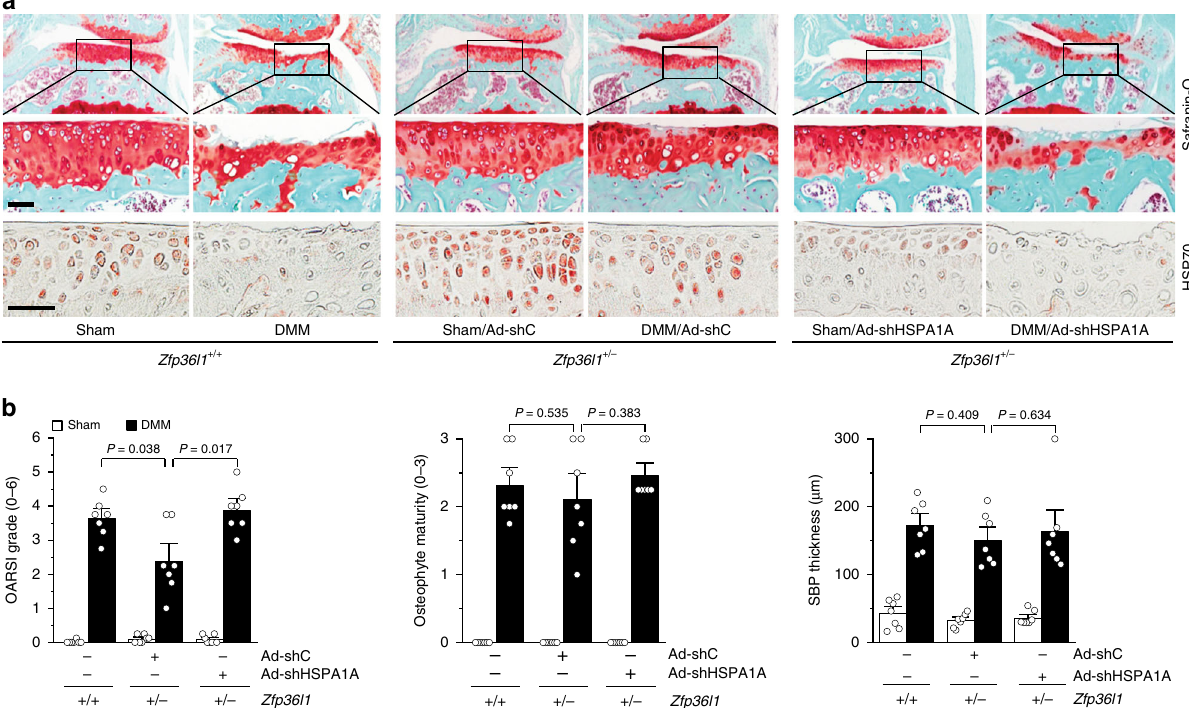
Fig. 7 Knockdown of HSPA1A abrogates the inhibition of OA pathogenesis seen in Zfp36l1 + / − mice. Sham- or DMM-operated WT and Zfp36l1 + / − mice were IA injected with Ad-shC or Ad-shHSPA1A ( n = 7 mice per group) and sacri fi ced at 8 weeks after the operation. a Representative images of Safranin-O staining and immunostaining of HSP70. b Quantitation of OA parameters (OARSI grade, osteophyte maturity, and subchondral bone plate thickness). Means ± 95% CI with Mann – Whitney U test for OARSI grade and osteophyte maturity. Means ± s.e.m. with two-tailed t -test for SBP thickness. Scale